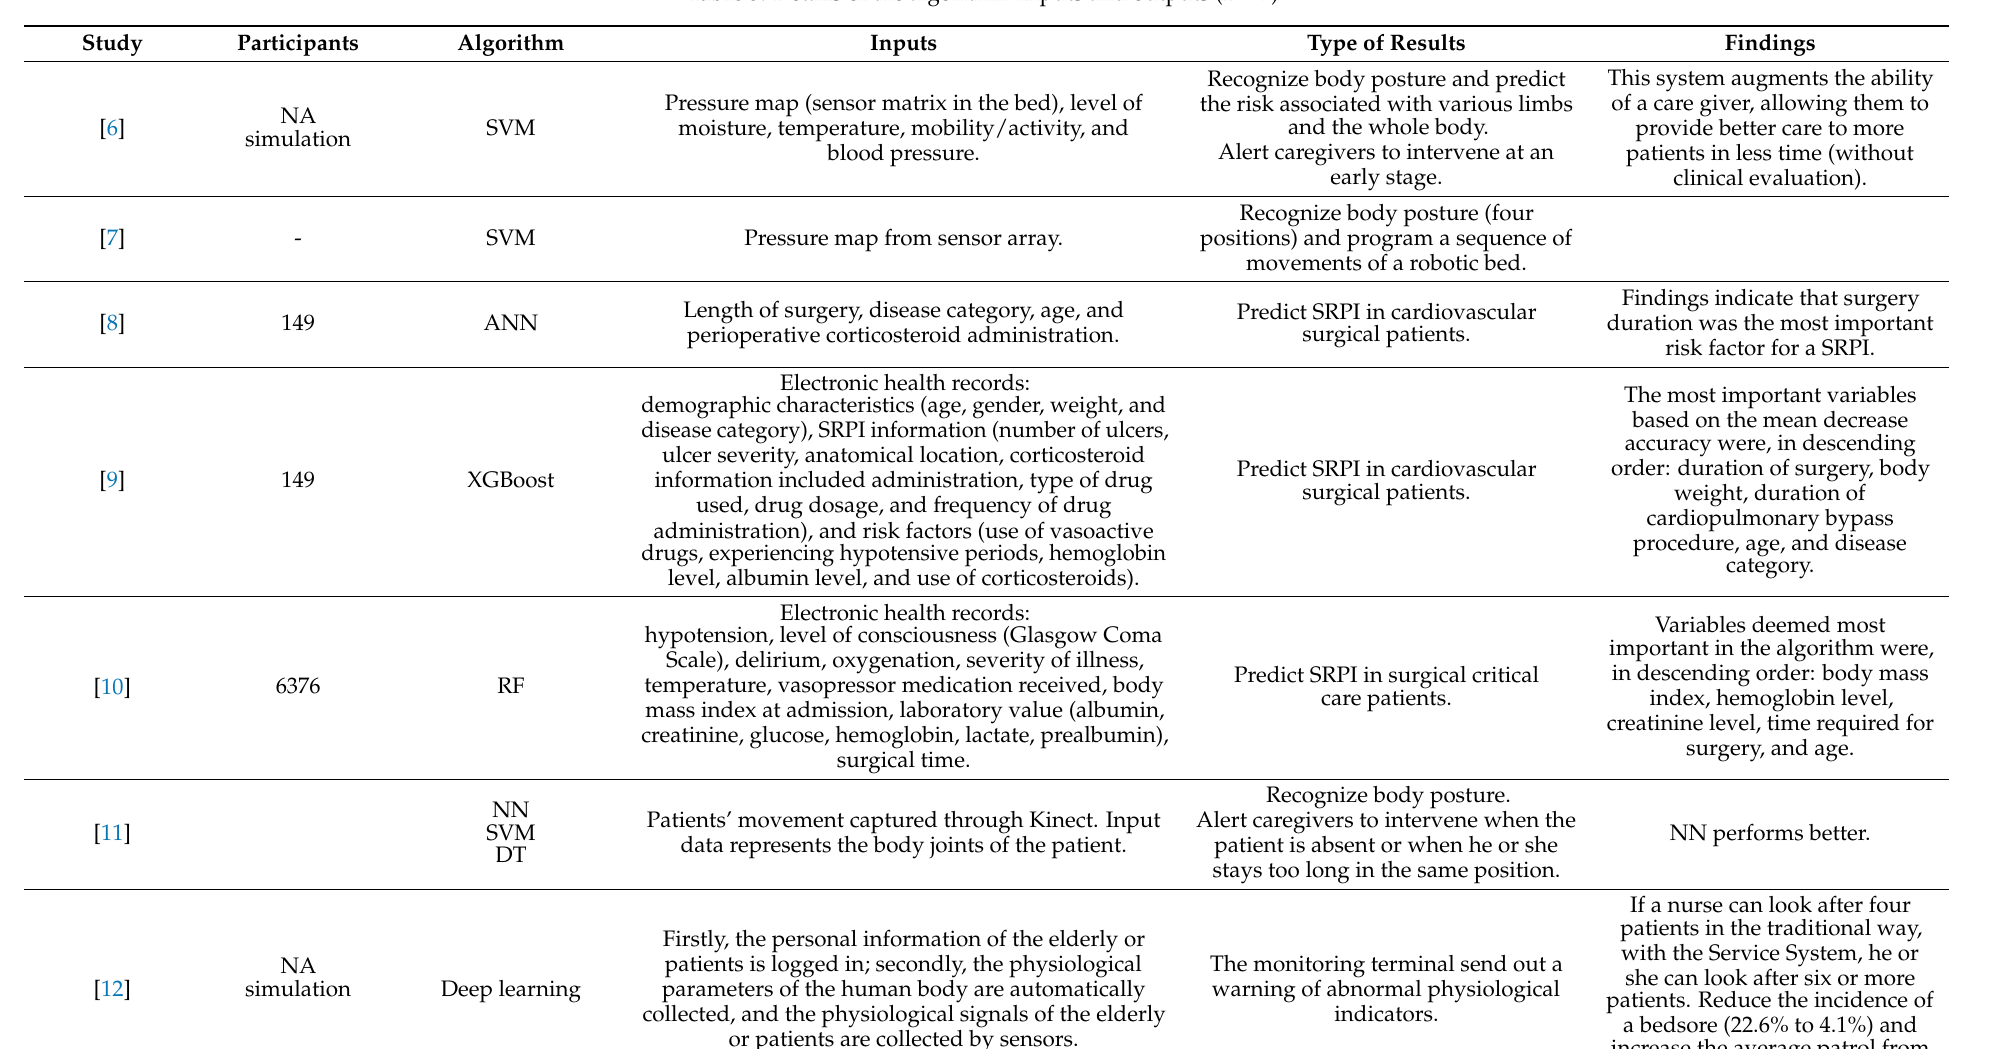
Table 5. Details of the algorithm: inputs and outputs ( n =